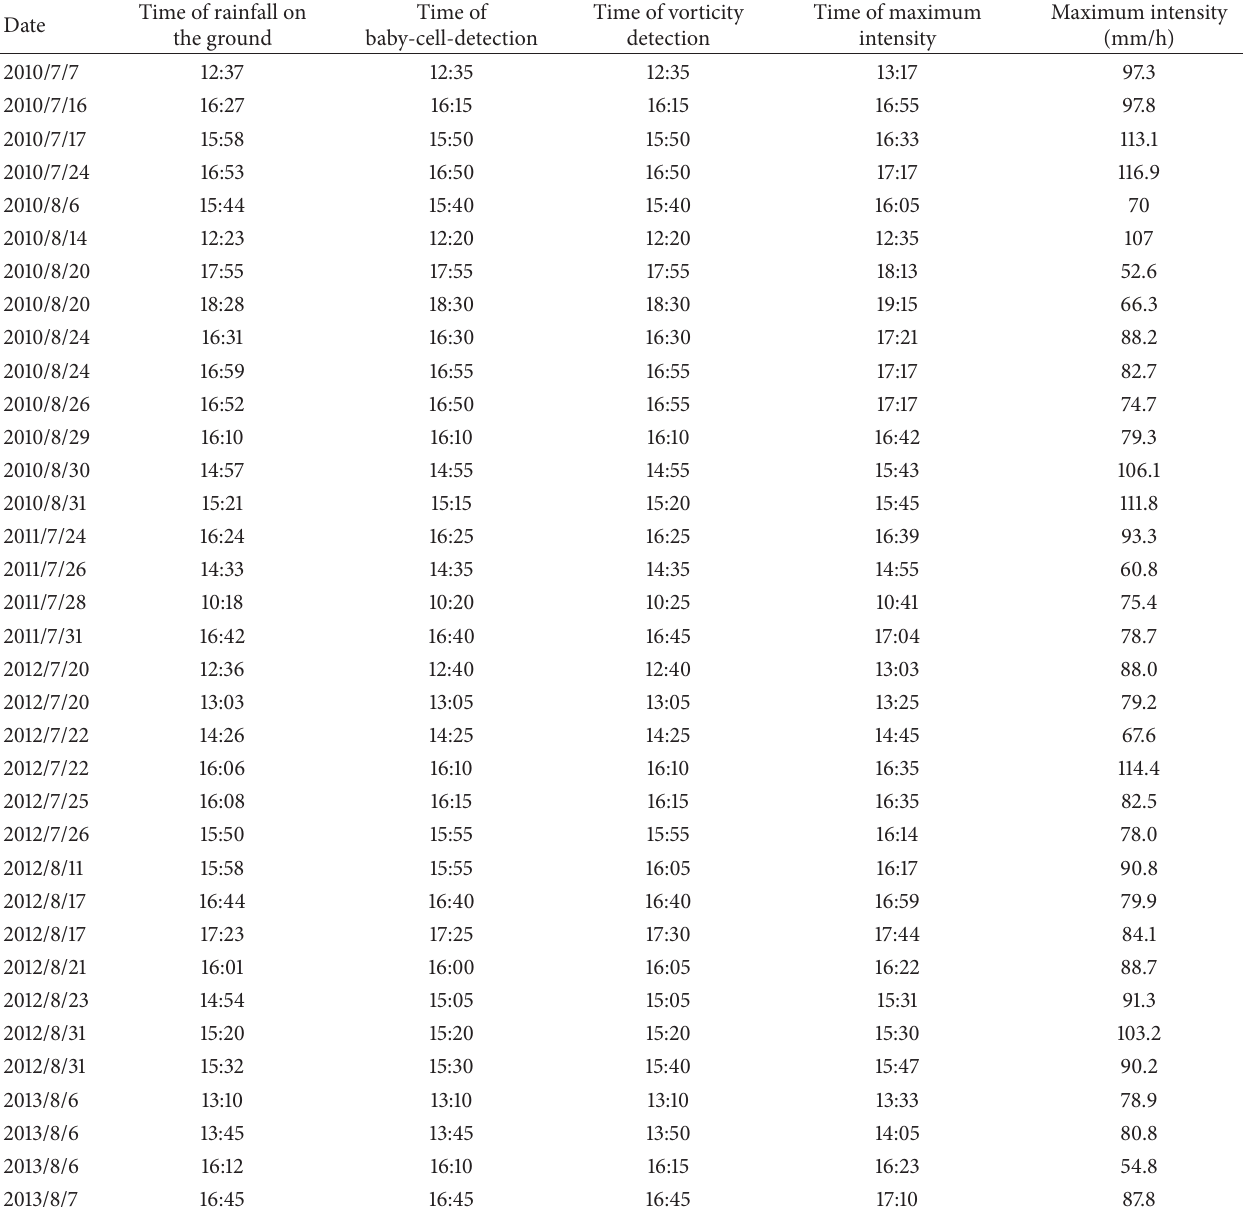
Table 2: List of Guerrilla-heavy rainfall events used for vorticity evaluation. This includes occurrence date, time of first echo detection, first time of detection of vorticity greater than or equal to 0.03 s −1 , and time and maximum rainfall intensity on the